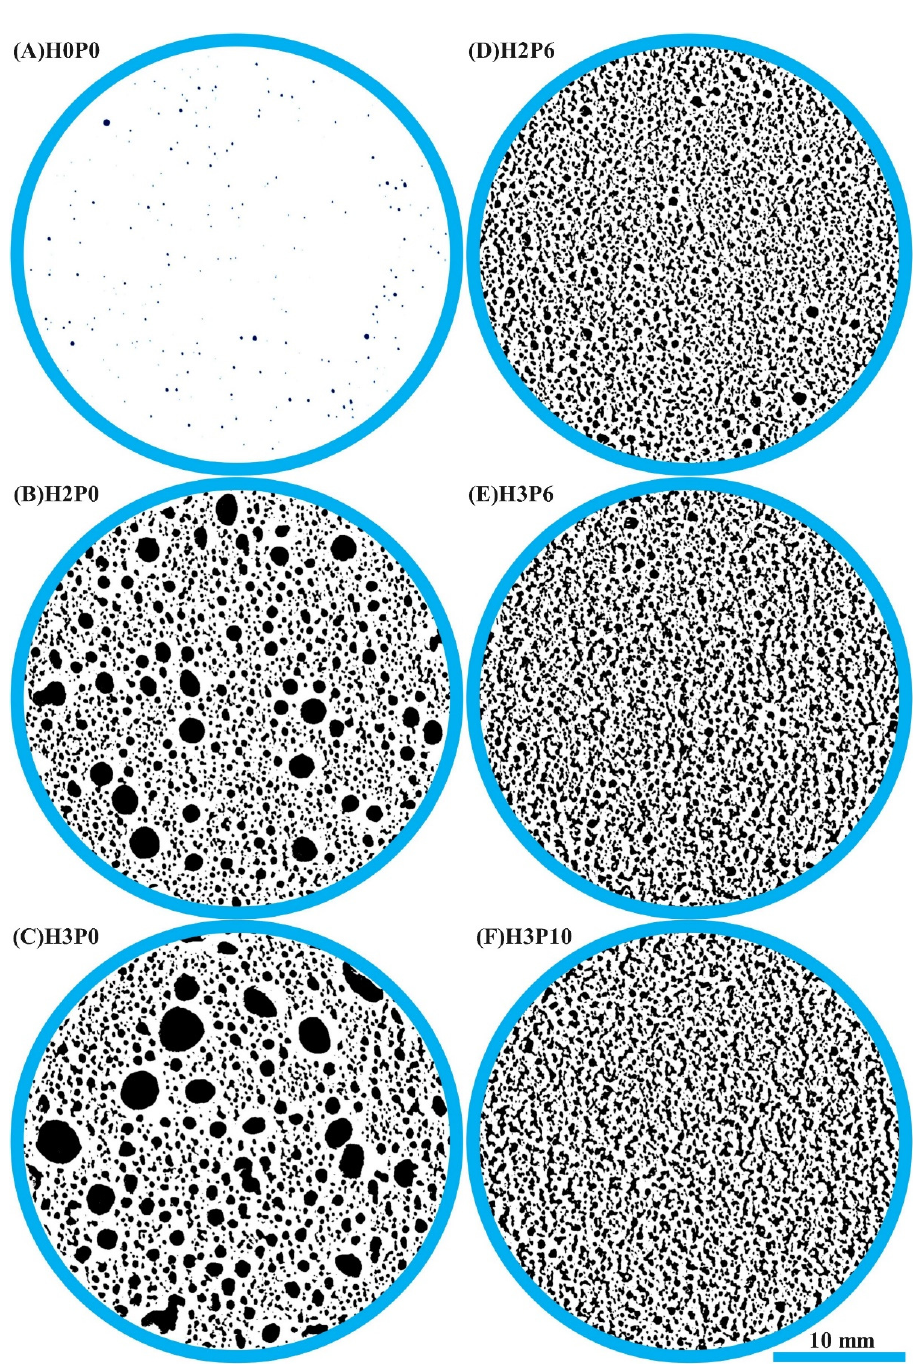
Figure 12. Cross-sectional binarized images of matrix and geopolymer foams: ( A ) H0P0, ( B )